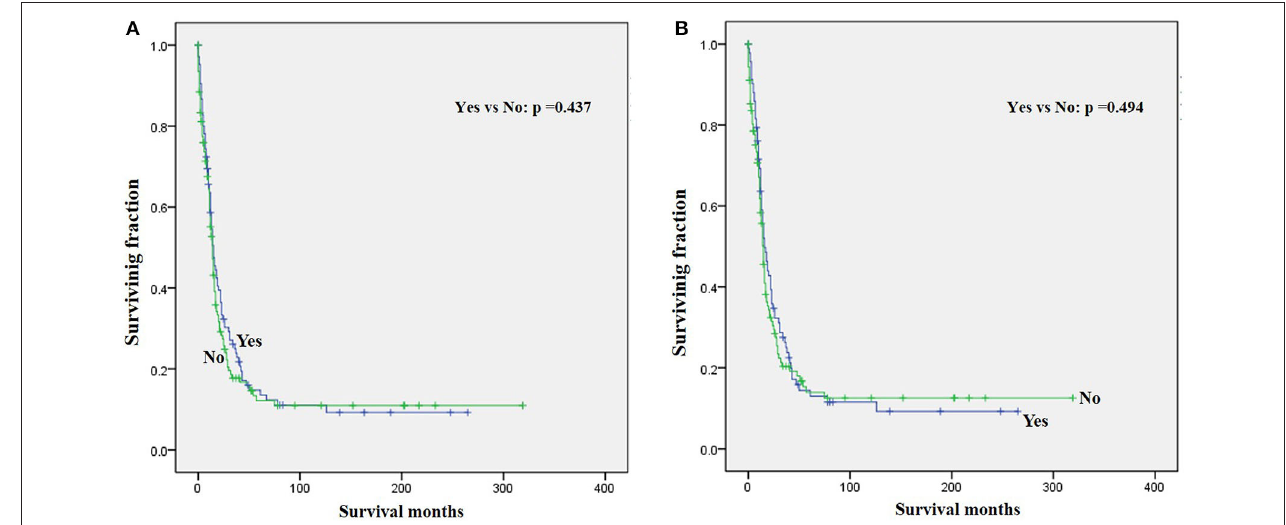
FIGURE 3 | Graphs show Kaplan–Meier curves of (A) OS and (B) CSS in patients with LRMS and metastasis at diagnosis stratified by surgery.